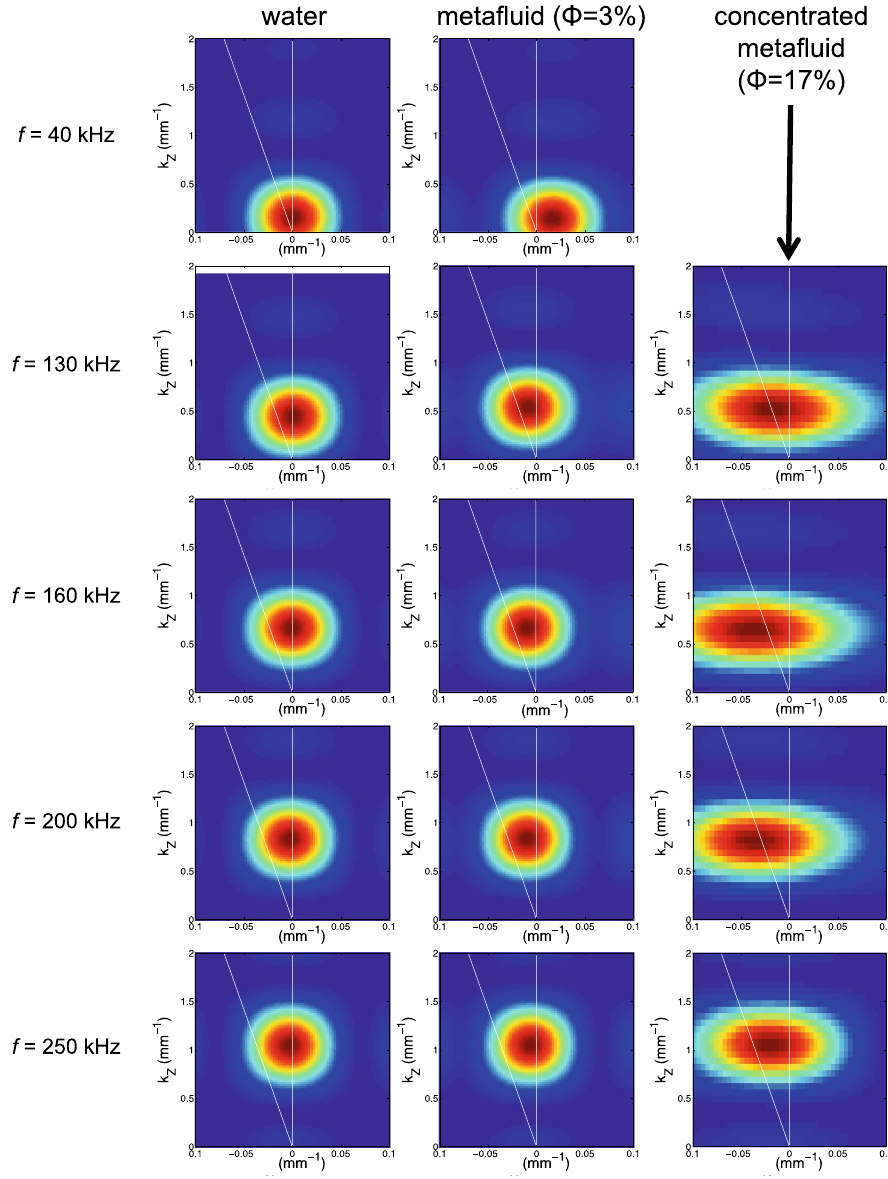
Figure 3. 2D Fourier transforms of the scanned field pattern performed at different frequencies: 40, 130, 160, 200, 250 kHz (from the top to bottom). The prism is filled with either water (left), diluted metafluid (center) or 0 ) corresponds to the case in which concentrated metafluid (right). On all maps, the white vertical axis ( k x = 1 , whereas the tilted white axis ( arctan ( k x / k z ) θ fluid ) corresponds to θ water θ fluid meaning that n fluid = − = = + 0 meaning that n fluid 0 . The Fourier transforms imply a plane wave in the positive z the case in which θ water = =